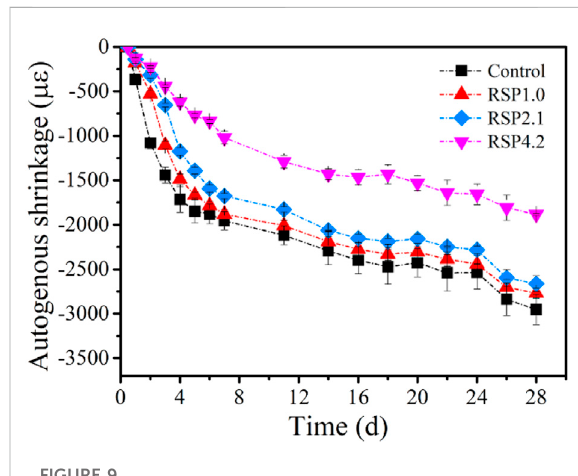
FIGURE 9 Autogenous shrinkage of AAS mixtures with and